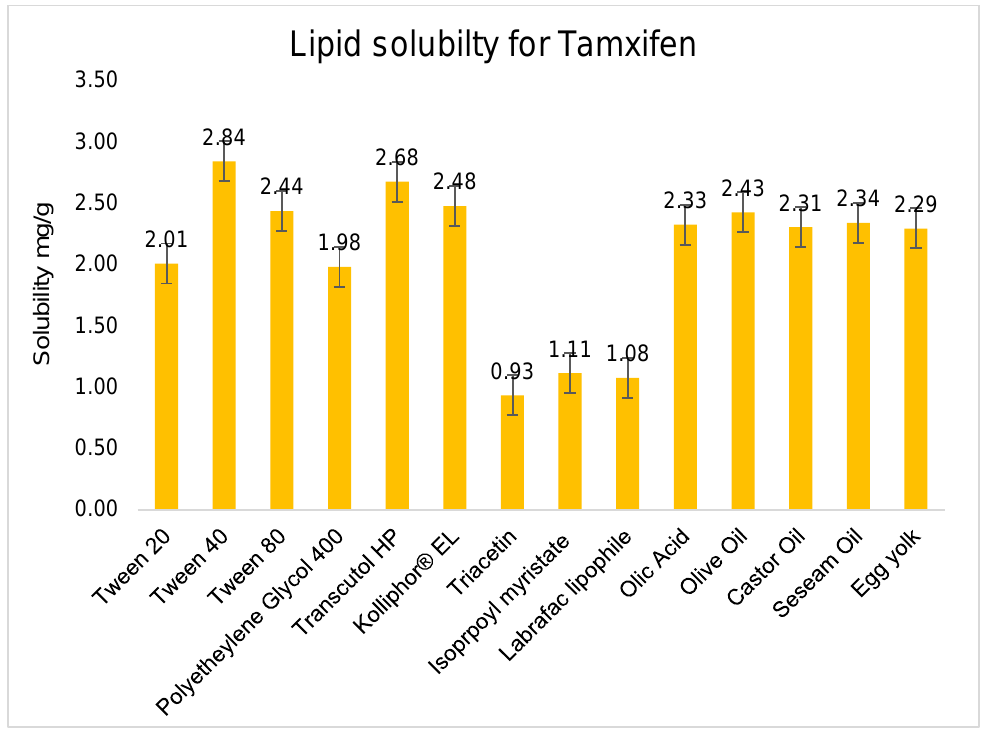
Figure 2. Solubility data of Tamoxifen agents in various formulation excipients; data are expressed as mean ± SDD ( n = 3).